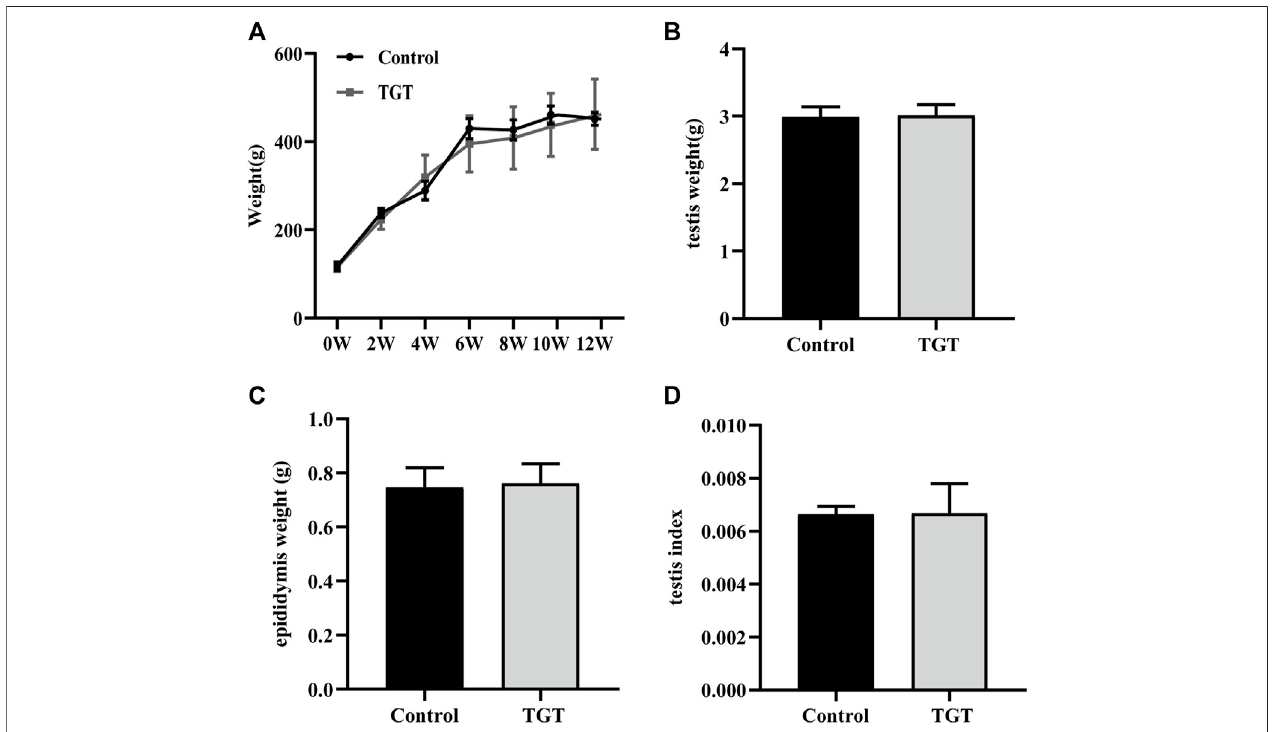
FIGURE1|(A) Changesintheweightsoftheratswithin12 weeks. (B) Theweightsofthetestisonweek12oftheexperiment. (C) Theweightsoftheepididymison week 12 of the experiment. (D) The testis index on week 12 of the experiment. All values represent the means ± SD ( n =